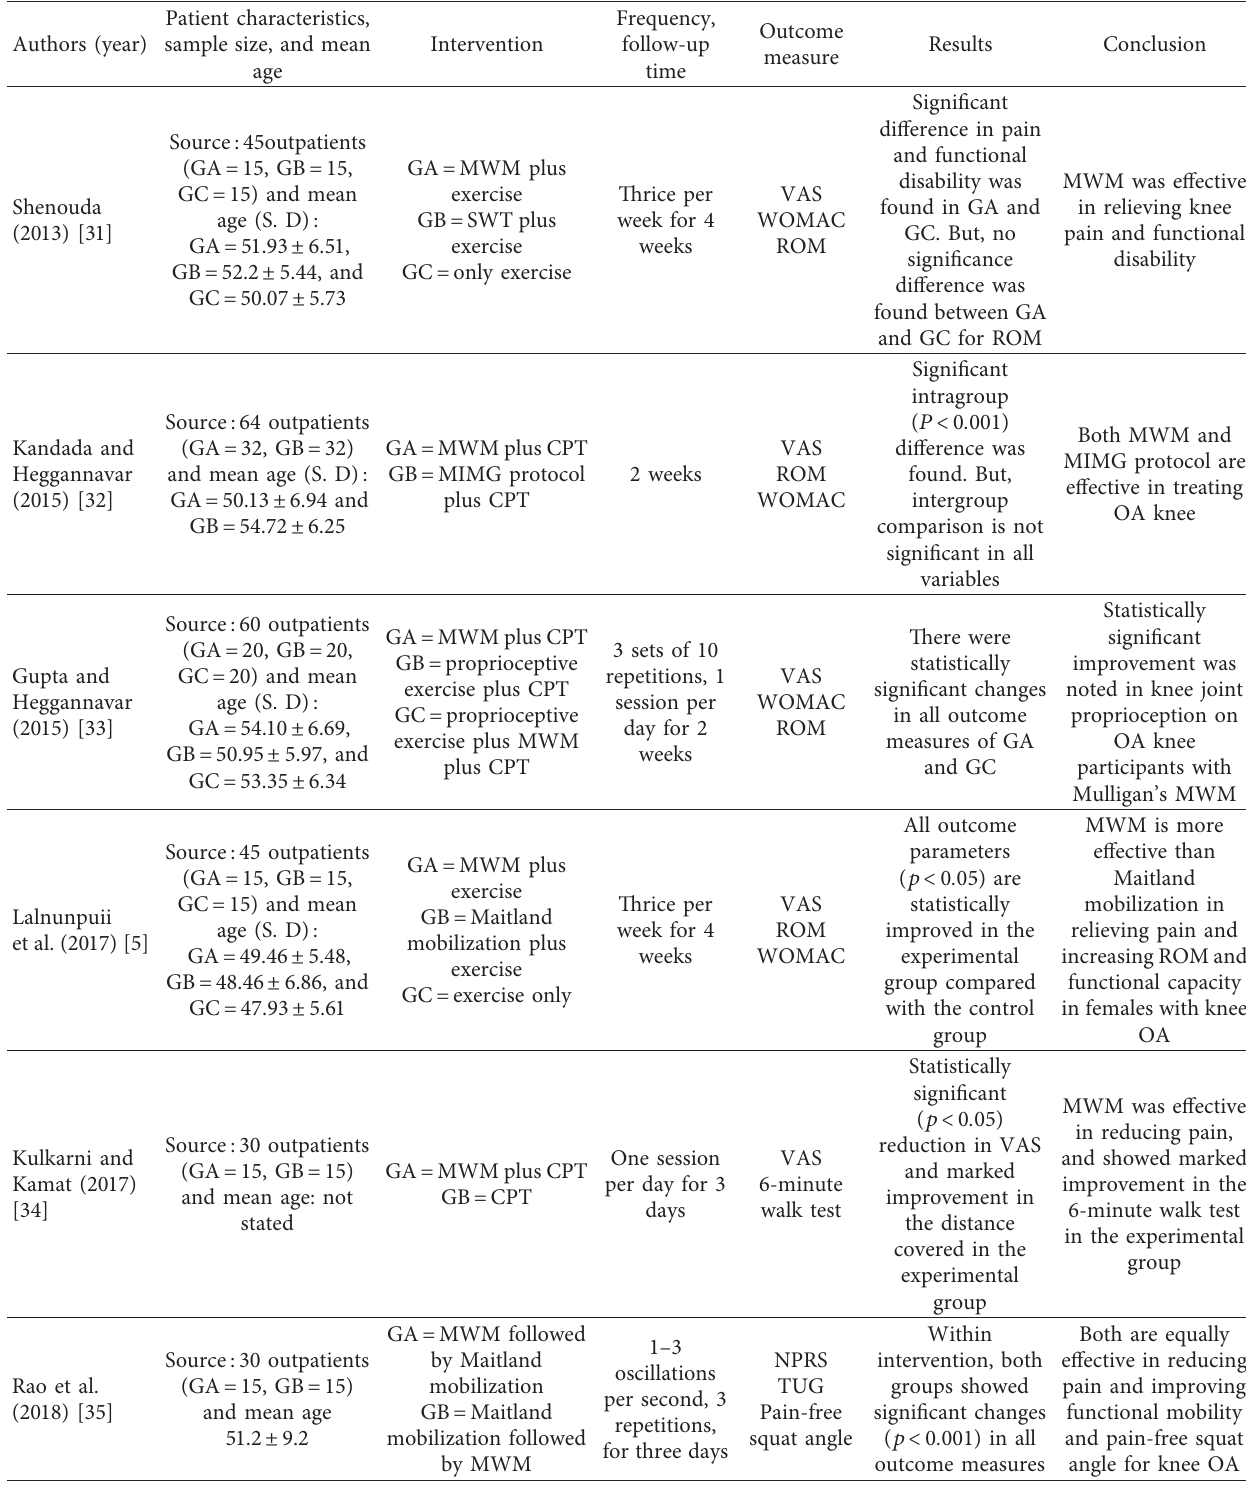
Table 2: Summary of included randomized control